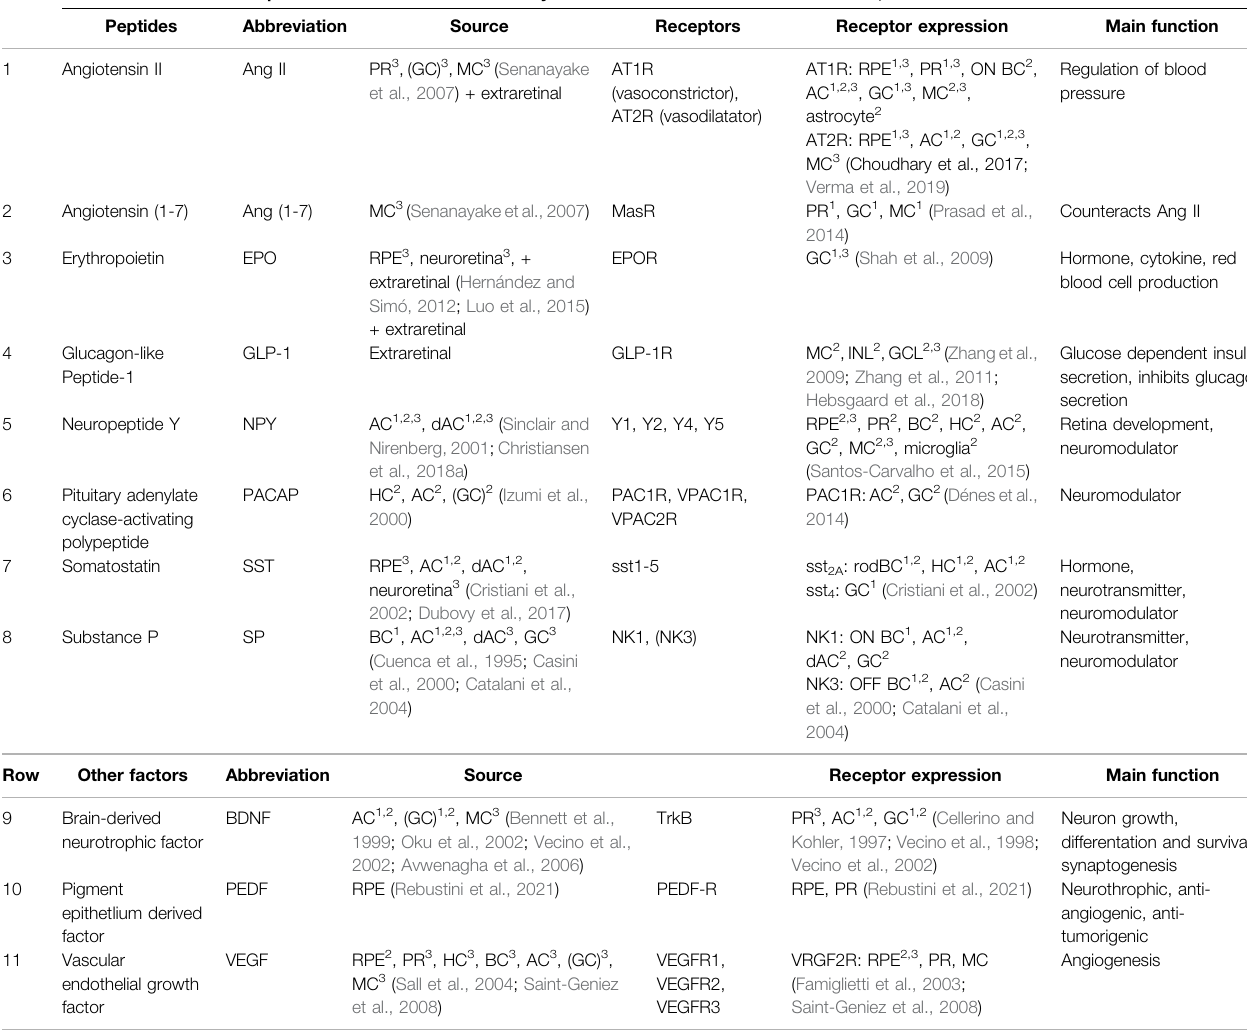
A variety of neuropeptides and other proteins are expressed in the mammalian retina, along with their receptors, and these molecules play a diverse role in maintaining normal retinal function.AmacrinecellsACs,müllercellsandthecellsofthepigmentepitheliumcontributethemostsigni fi